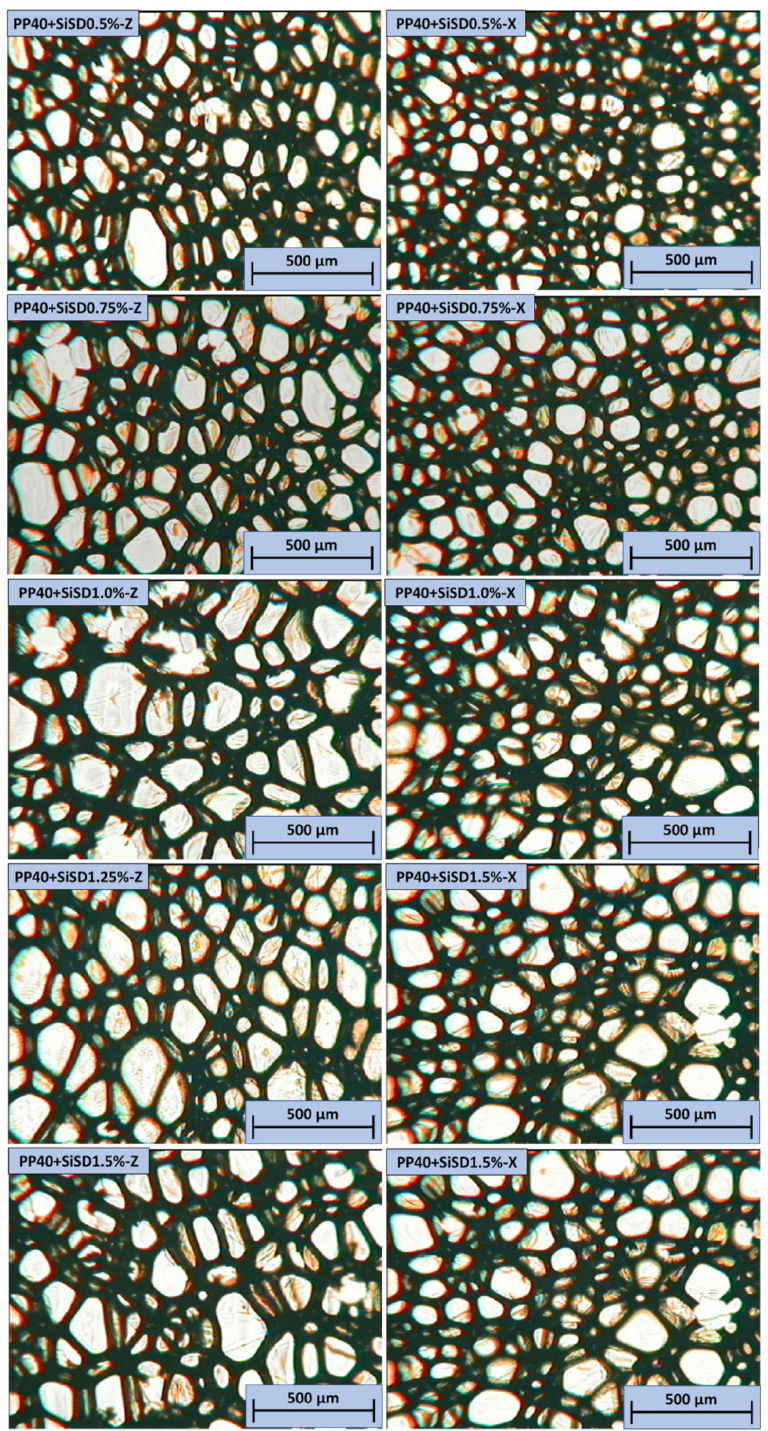
Figure 18. OM images of neat PP40 and SiSD composites in both Z ( left ) and X ( right ) directions. In all PP40 composites with SiSD, few defects were observed. Similarly to neat PP40, PP40 composites with SiSD presented slightly higher mechanical properties in the Z direction, which can be associated with an increased anisotropy index (see Table 4). The images of PP40 composites with SiMC and SiNC obtained with OM are depicted in Figure